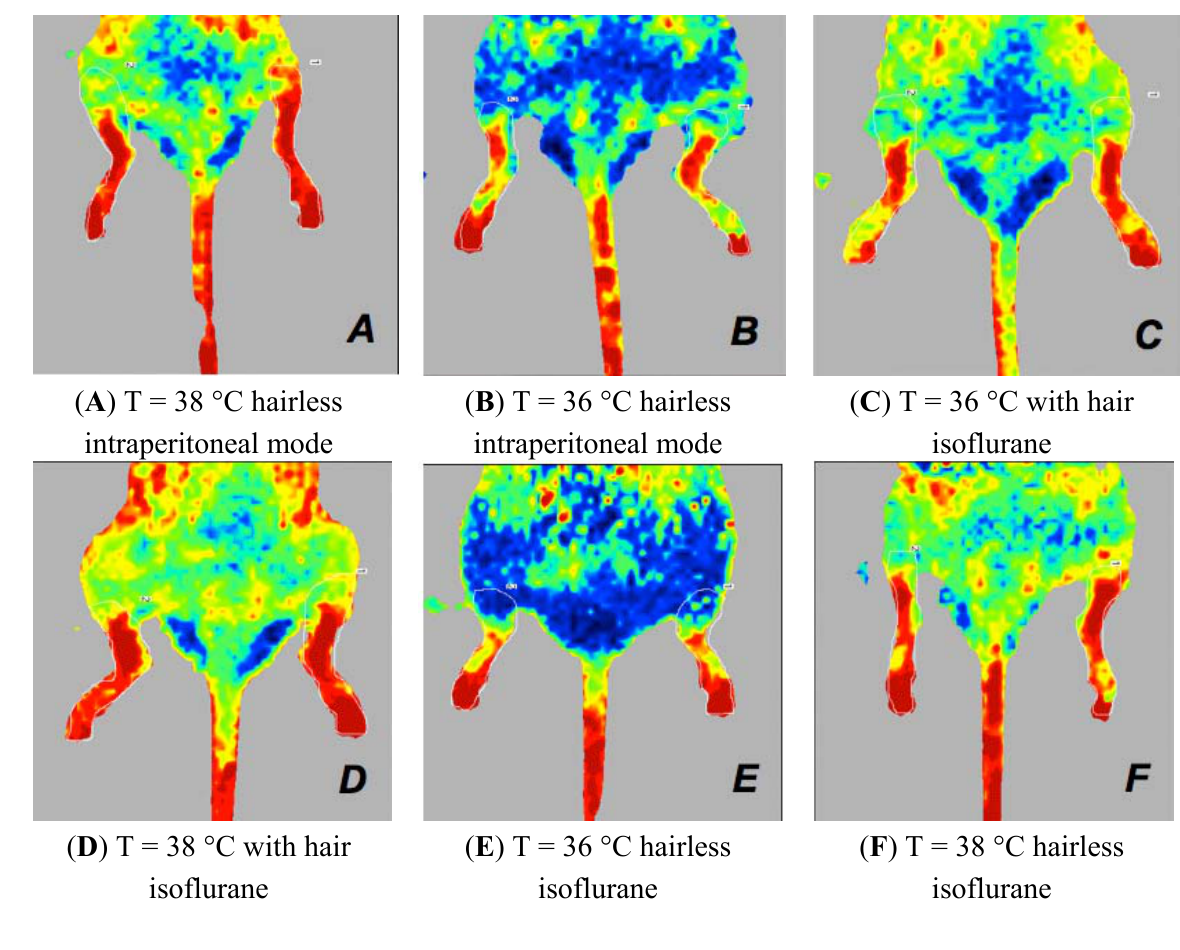
Figure 9. Laser Doppler images of the hind limbs of mice associated with the body temperature when the mouse is positioned in the ventral decubitus position. In mice anaesthetised with intraperitoneal drugs ( A , B ), there is a significant difference in both mice. Mice that have a body temperature of 38 °C (A) always have higher perfusion values . In mice anaesthetised with isoflurane ( C , D , E , F ), with ARC (C,D) or ARD (E,F) depilation, and those with a body temperature of 38 °C (D,F) show the highest perfusion